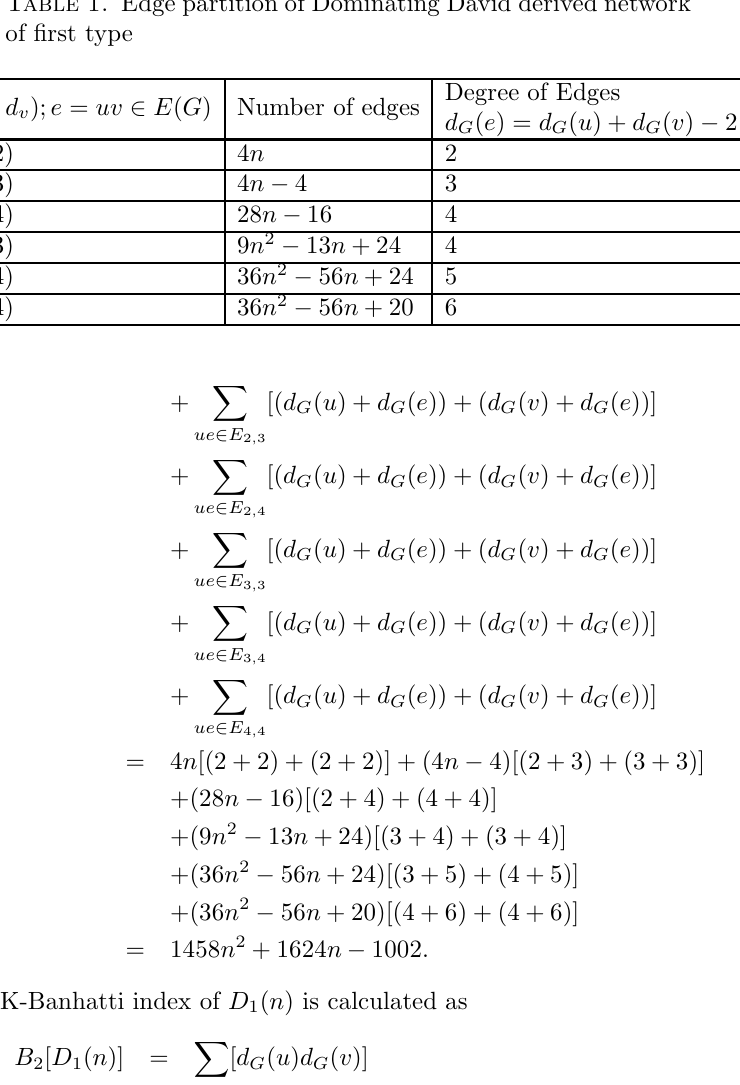
Table 1. Edge partition of Dominating David derived